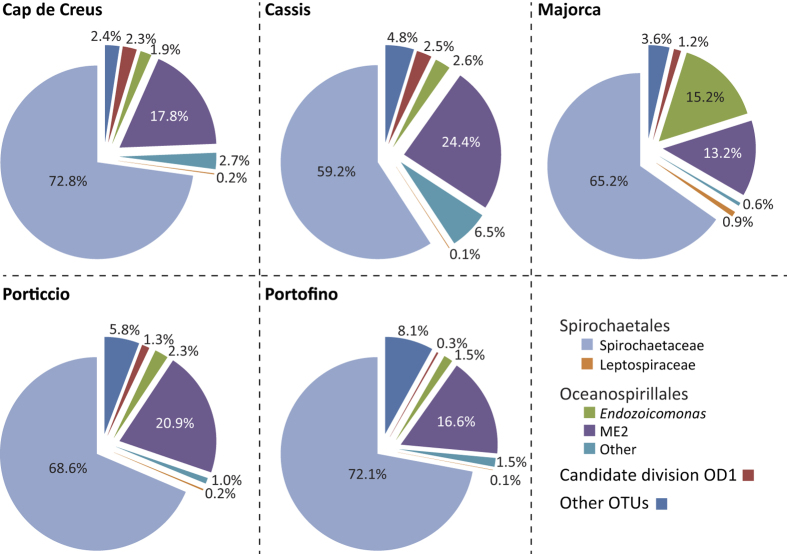
Overview of the composition of the microbiomes associated with Corallium rubrum showing relative spatial stability.The contribution of each taxon to the microbiome at each location is indicated in percentages (%).